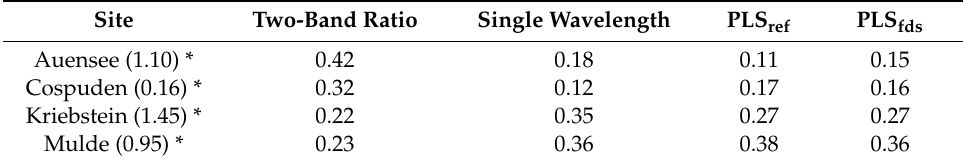
Table 4. RMSE (in m − 1 ) for CDOM estimation per